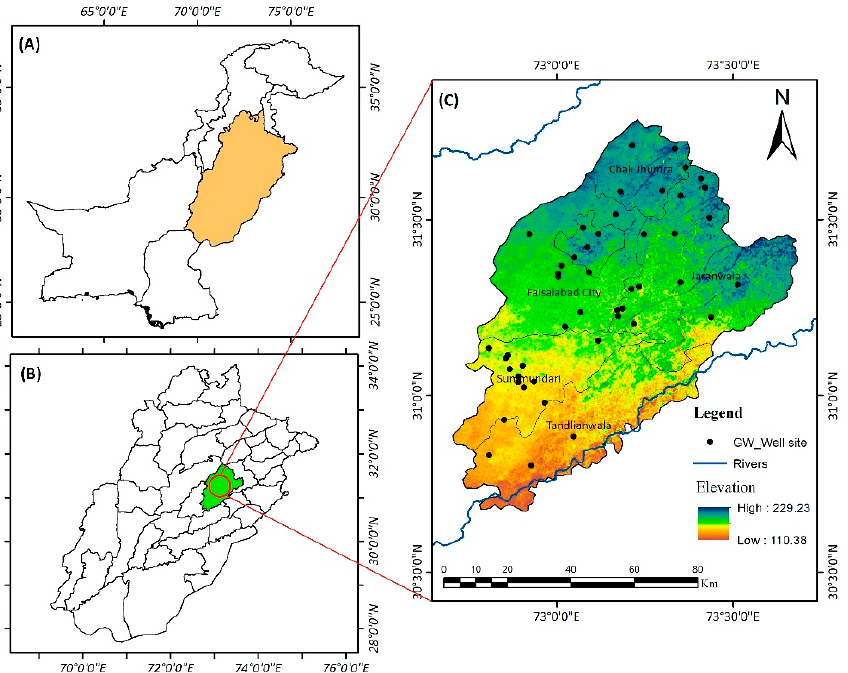
Figure 1. Location of the study area and the administrative boundaries of Pakistan ( A ), Panjab province ( B ), and Faisalabad district ( C ).